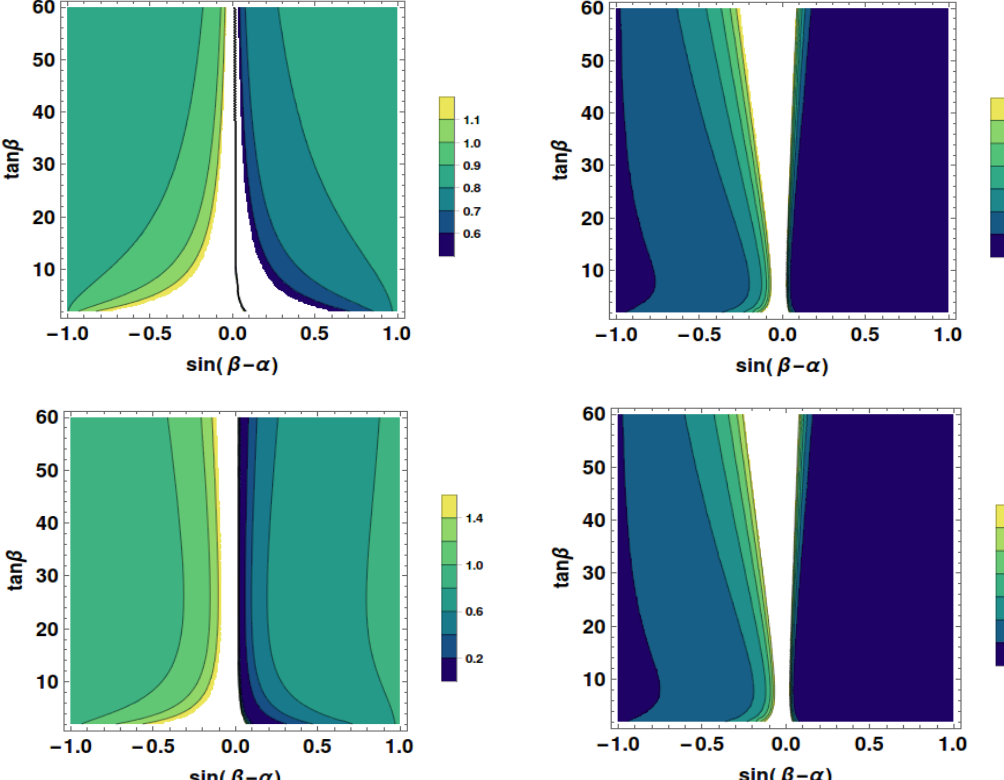
Figure 16 . The ratio r in sin( (cid:12) (cid:0) (cid:11) )-tan (cid:12) plane for Type I(top left), Type II(top right), Lepton- speci(cid:12)c(bottom left) and Flipped 2HDM(bottom right), where m